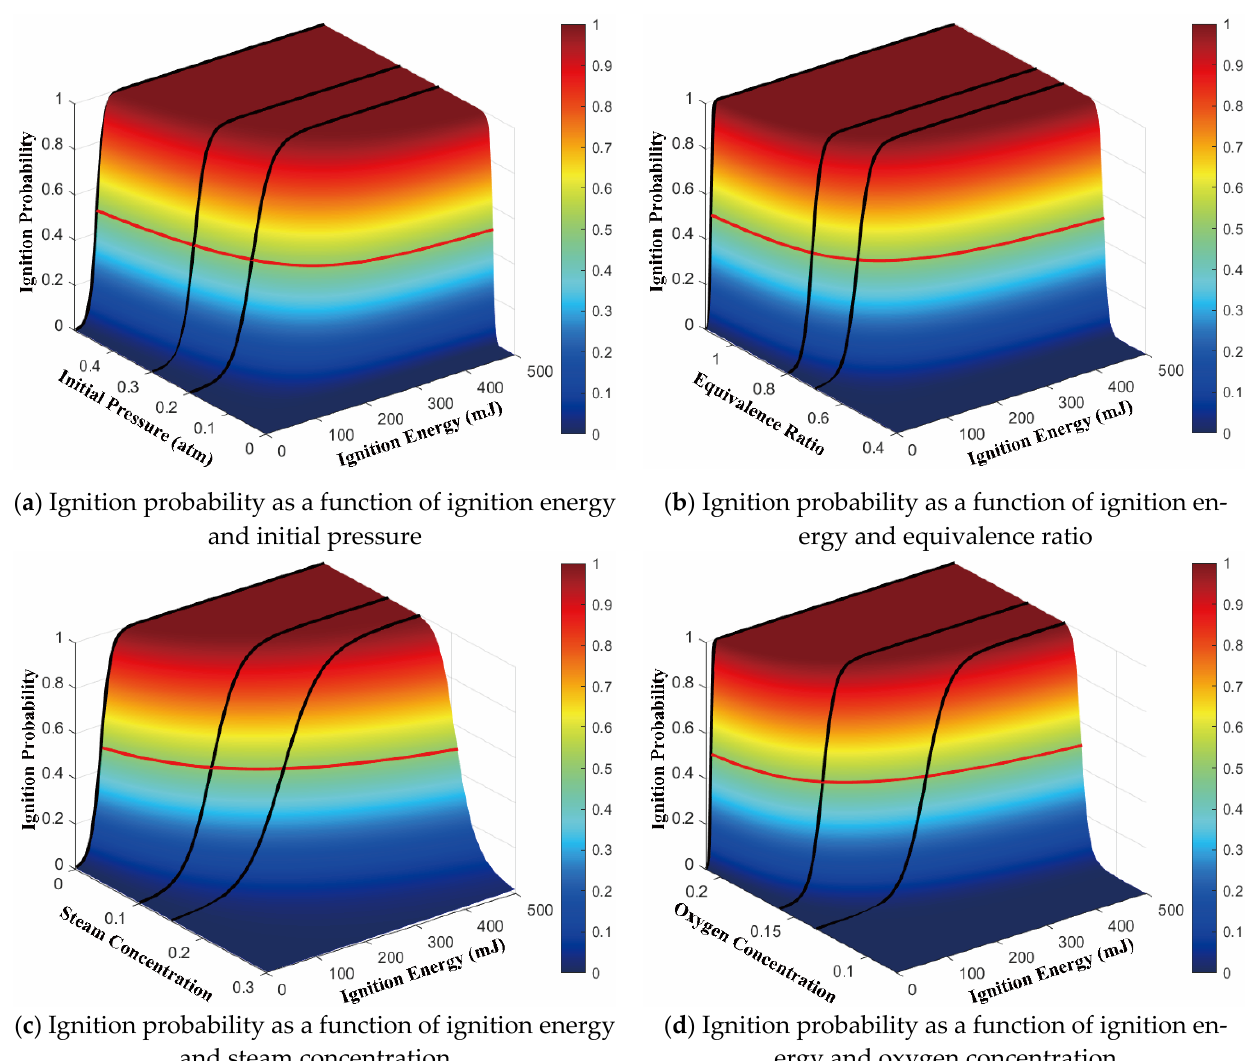
( d ) Ignition probability as a function of ignition en- ergy and oxygen concentration Figure 9. Fitting results of ignition probability versus different initial conditions and ignition energy.